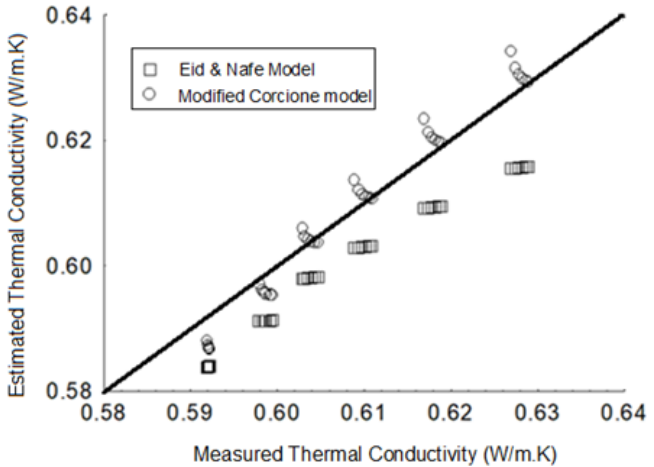
Figure 7. Comparison of measured and estimated thermal conductivity for hybrid nanofluid.